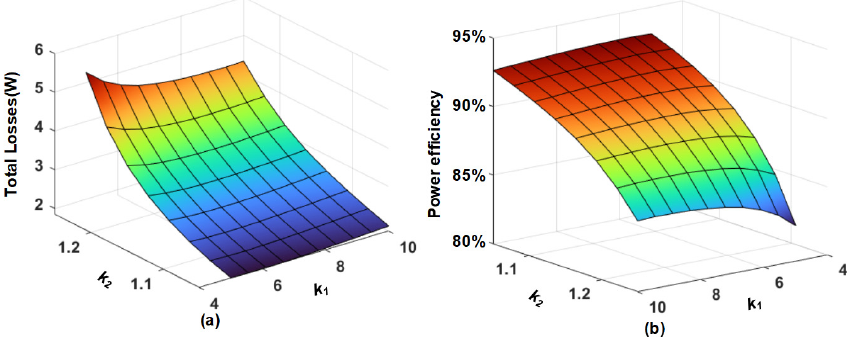
Figure 9. Total loss and overall power efficiency with respect to k 1 and k 2 : ( a ) total loss; ( b ) power efficiency. Combining analyses of RMS branch currents and total loss, optimal values of k 1 and k 2 are derived